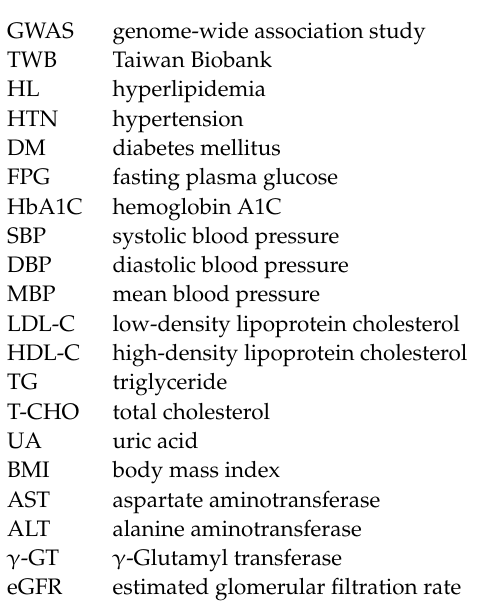
Supplementary Figure S11. Regional-wide association studies on chromosome 1q22 for gout without (A) or with (B) conditional analysis. Supplementary Figure S12. Regional-wide association studies on chromosome 1q22 for microalbuminuria without (A) or with (B) conditional